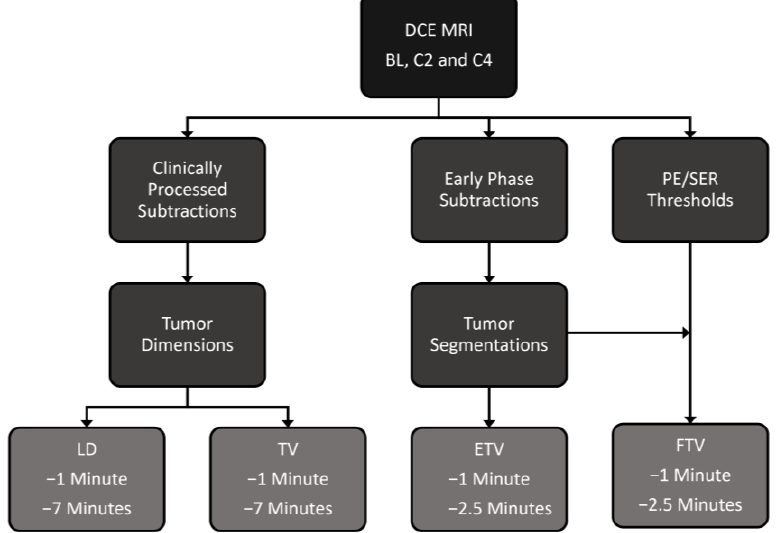
Figure 1. Flow chart shows the workflow of data acquisition, image processing, tumor segmentation, and measurement.